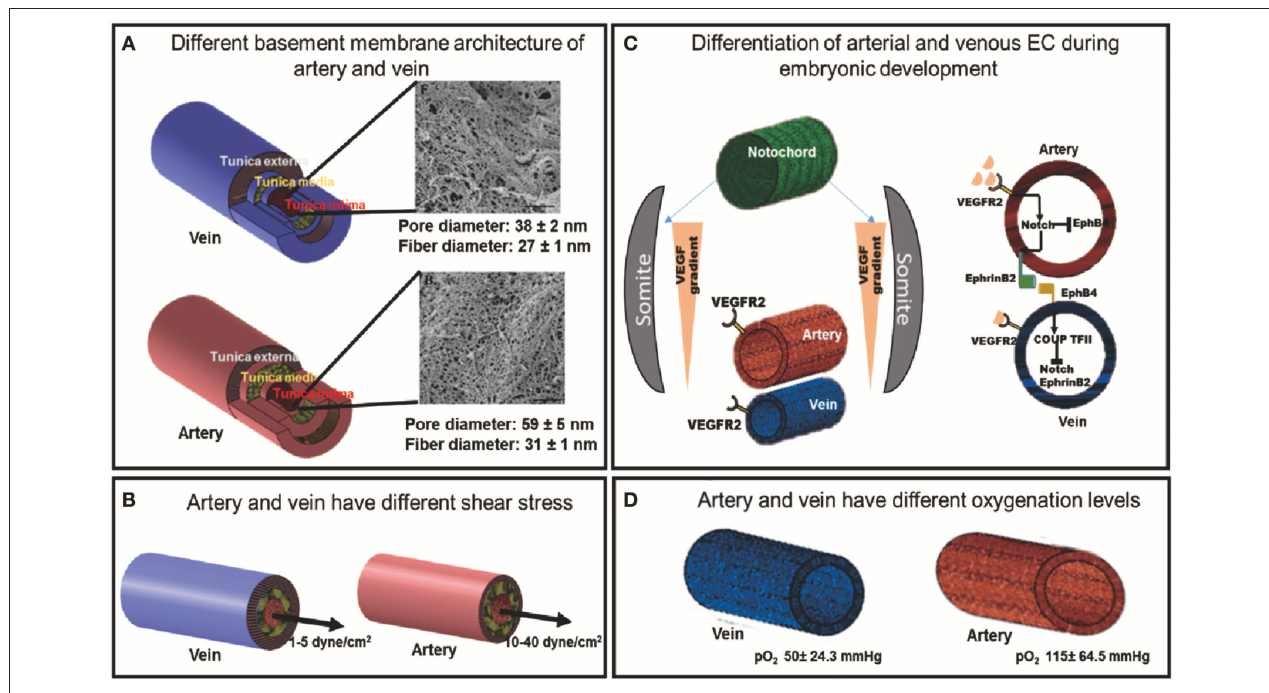
FIGURE 1 | The developmental and physiological functions of arteries and veins are governed by different environmental factors. (A) The different basement membrane architectures of the artery and vein [SEM images adapted from Liliensiek et al. (2009), reproduced with permission from Mary Ann Liebert, Inc., New Rochelle, NY]. (B) Different shear stress experienced by arteries and veins. (C) Different differentiation pathways of artery and vein during embryonic development. (D) Artery and vein experience different oxygenation levels of the